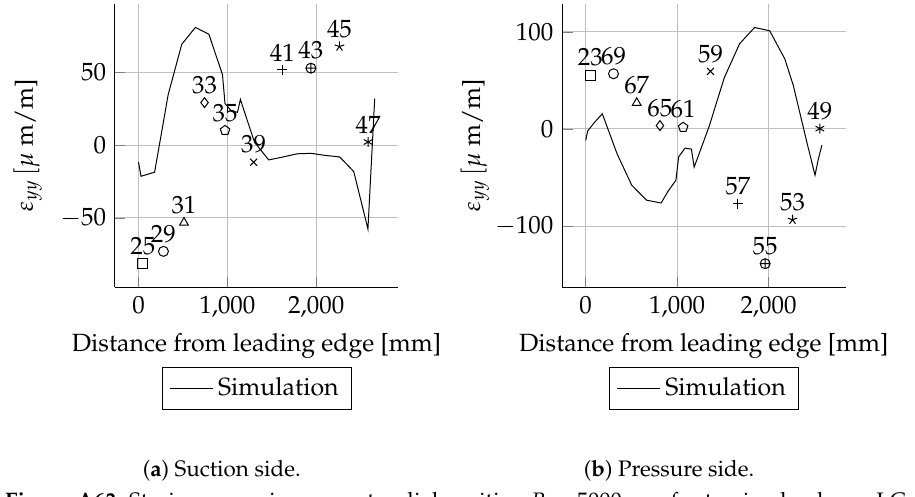
Figure A63. Strain comparison ε TT at radial position R = 5000mm for torsion load case LC_3.